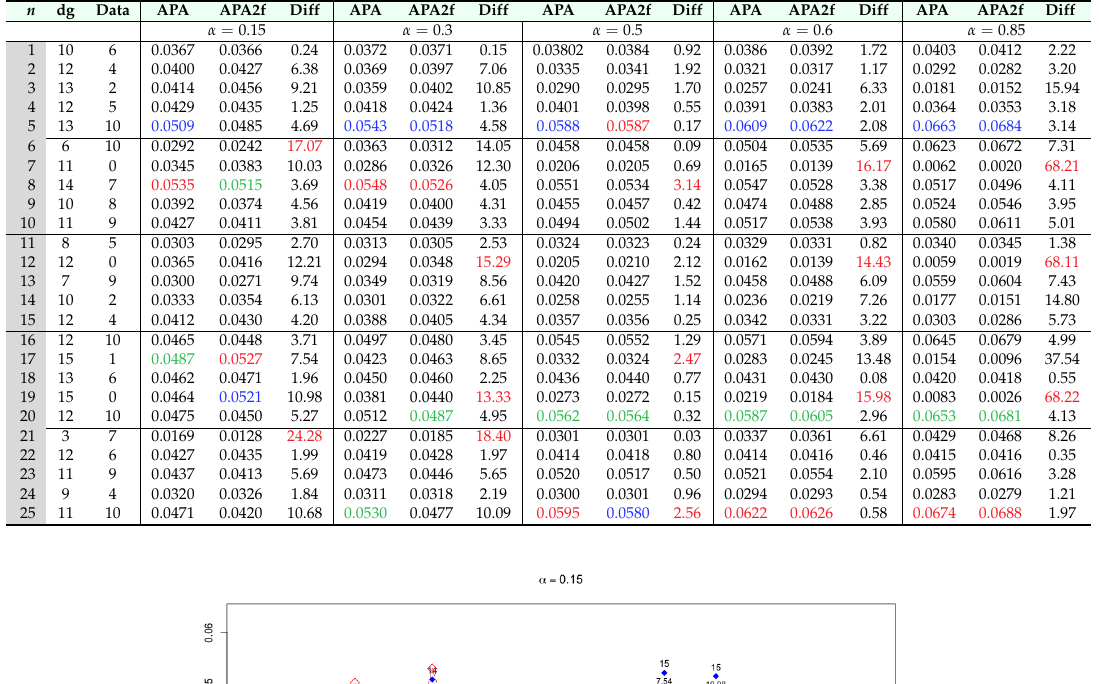
Table 1. APA, APA2f and differences between them (in percentage) for the graph of Figure 2.